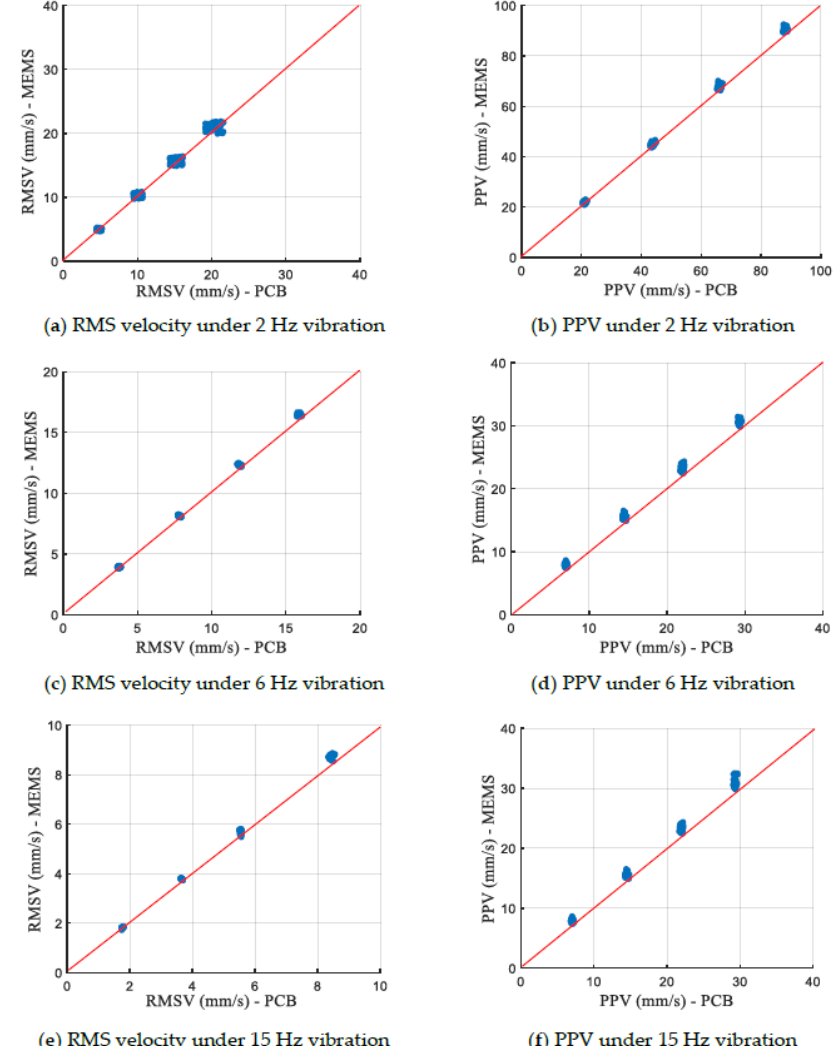
Figure 13. Comparison of PCB accelerometer and MEMS accelerometer in terms of RMS velocity in the 1 / 3 octave band and